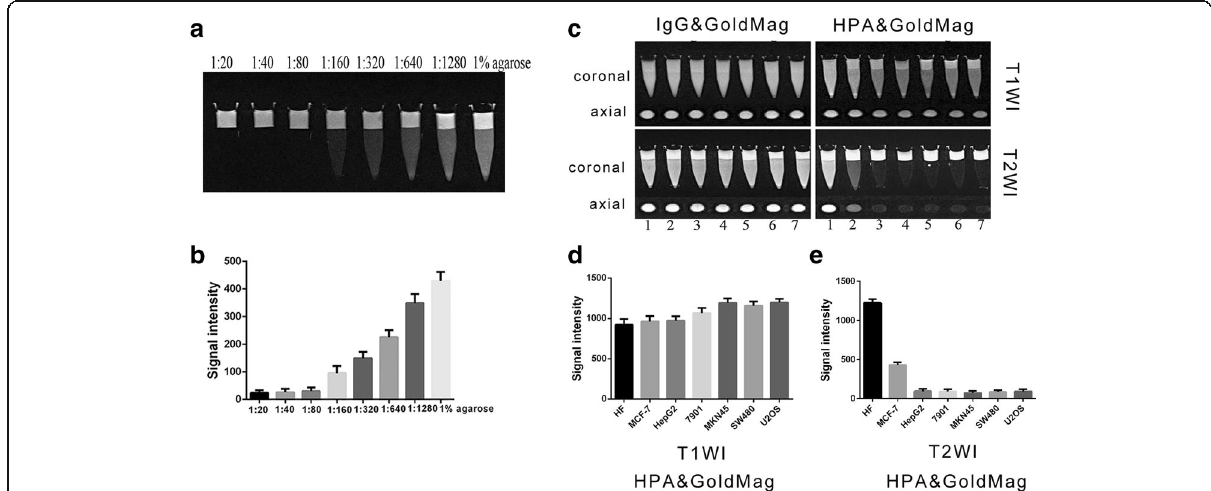
Fig. 4 a MR imaging of magnetic gold nanoparticles after two serial dilutions. b Diagram of the statistical results of MR imaging signal strengths of two serially diluted magnetic gold nanoparticles. c MR imaging of all cells after labeling with the probes. Lane 1, HF; lane 2, MCF-7; lane 3, HepG2; lane 4, SGC-7901; lane 5, MKN45; lane 5, SW480; lane 6, U2OS. d Statistical results comparing the signal strengths from MR imaging using the T1WI sequence on cells labeled with HPA&GoldMag probes. e Statistical results for the signal strengths detected with MR imaging using the T2WI sequence on cells labeled with HPA&GoldMag